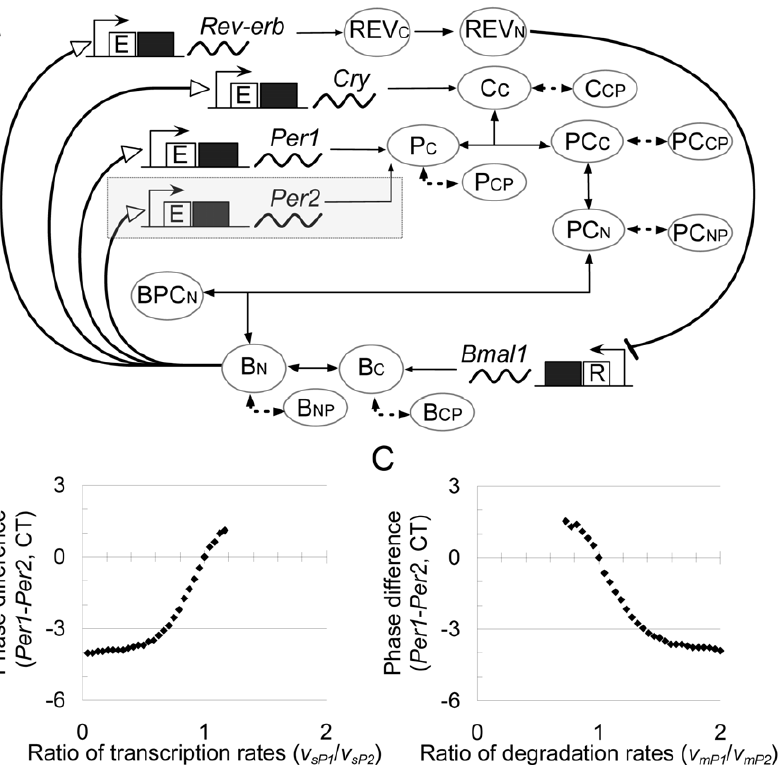
Figure 1. Effects of mRNA transcription and degradation rates on the Per mRNA expression phase. (A) Schematic representation of the circadian oscillatory network model used to compare the expression phases of Per1 and Per2 mRNAs, which was based on the Leloup and Goldbeter model [22]. The Per2 gene transcription and translation are additionally introduced in the shaded region. A square, wave line, and circle indicate a gene, mRNA, and protein, respectively. Details are described in Text S1. (B, C) Variation in the phase difference between the Per1 and Per2 mRNA oscillations with varied (B) the proportion of the Per1 transcription rate coefficient to the Per2 transcription rate coefficient ( v sP1 / v sP2 ) and (C) the proportion of the Per1 degradation rate coefficient to the Per2 degradation rate coefficient ( v mP1 / v mP2 ). The rate coefficient of transcription and degradation of Per2 were fixed to 2.4 nM/h and 2.2 nM/h, respectively. The phase difference of Per1 from Per2 is indicated in circadian time (CT).